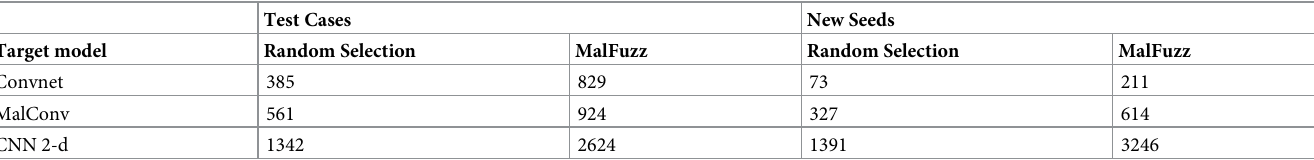
Table 4. Comparison of seed selection